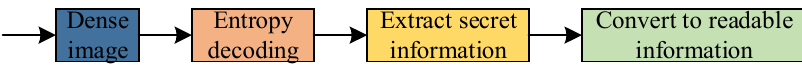
Figure 13. Information-extraction module hidden by image coding.